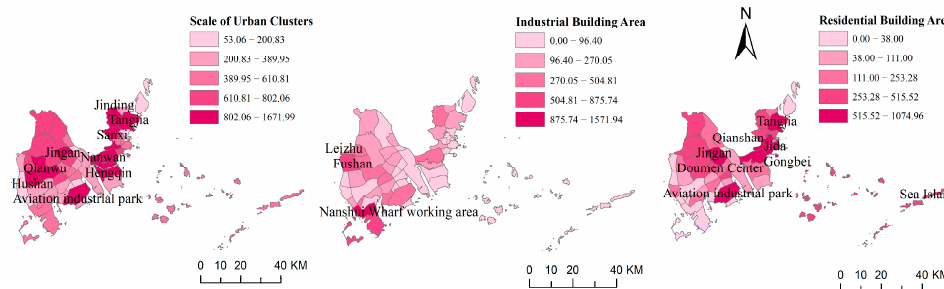
Figure 6. Spatial distribution of positive independent variables in Zhuhai.